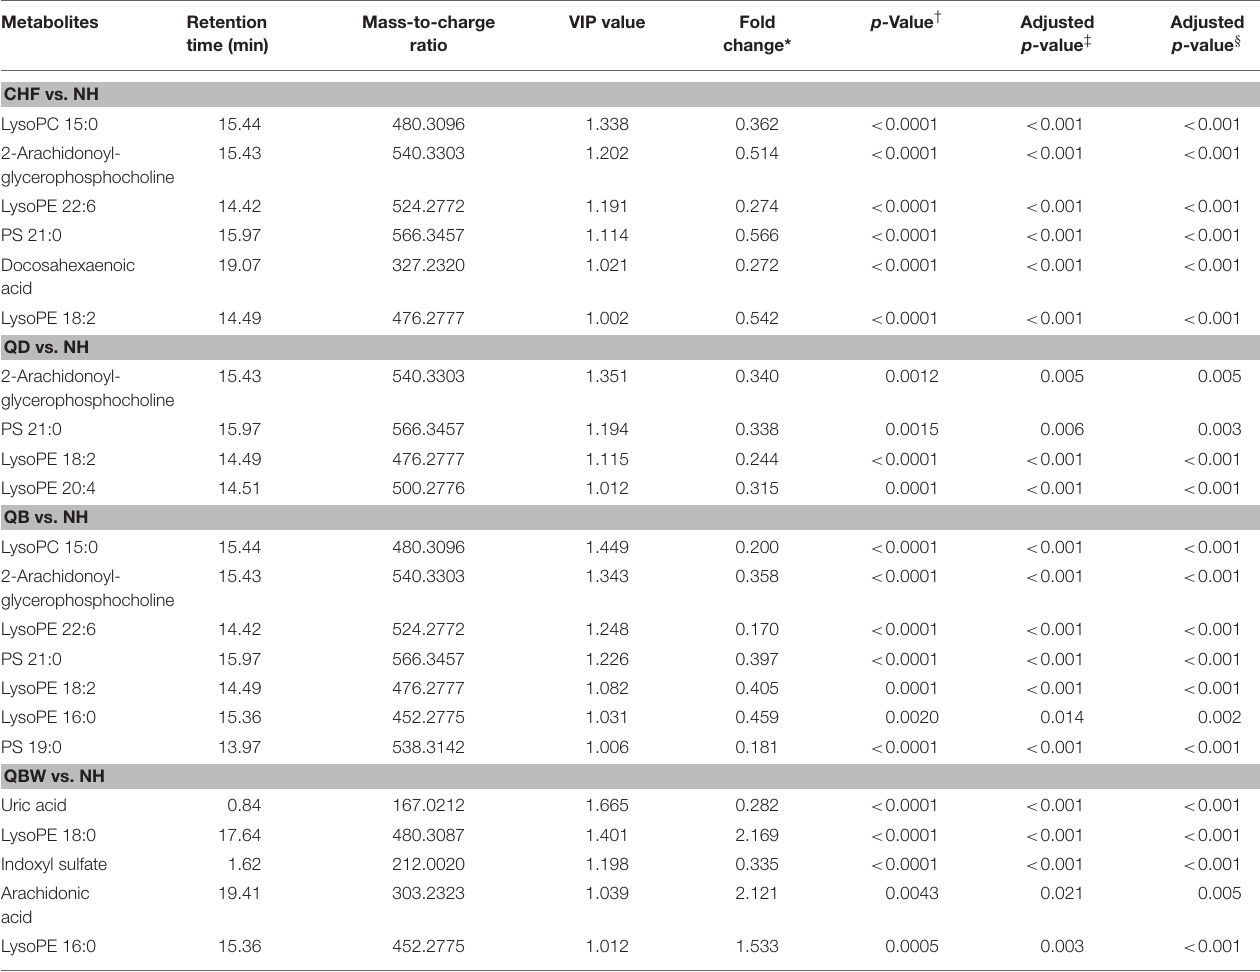
TABLE 2 | Statistical analysis of diagnostic biomarkers among NH and different CHF groups in discovery phase. p- Value † Adjusted Metabolites Retention Mass-to-charge VIP value Fold Adjusted p- value ‡ p -value time (min) ratio change*